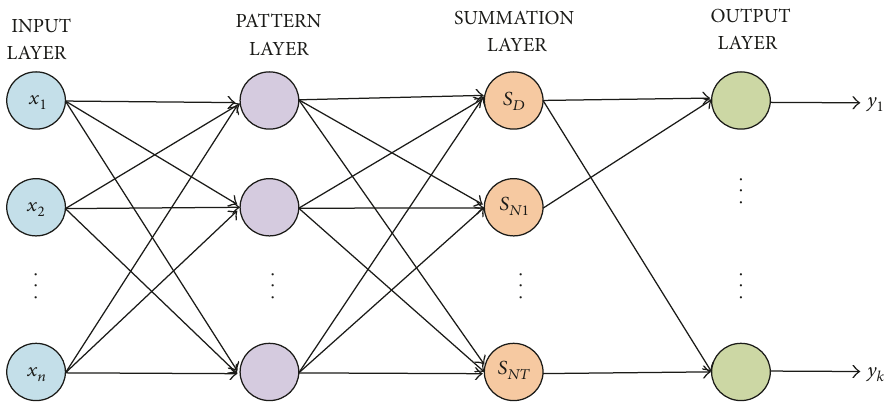
Figure 3: General configuration of